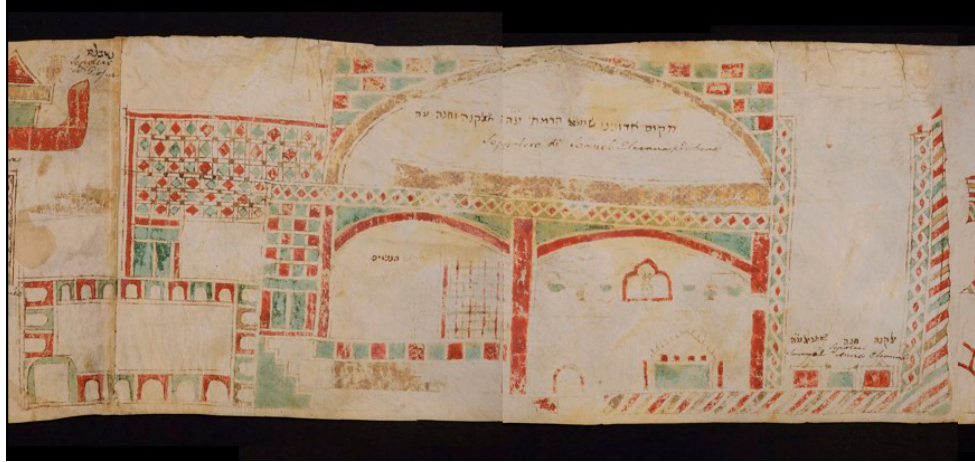
Figure 4. Florence, BNC, Ms. Magl. III, 43; Samuel’s tomb in Ramah (Nebi Samwil), early 14th century, by courtesy of Ministero dei beni e delle attività culturali e del turismo/Biblioteca Nazionale Centrale di Firenze.